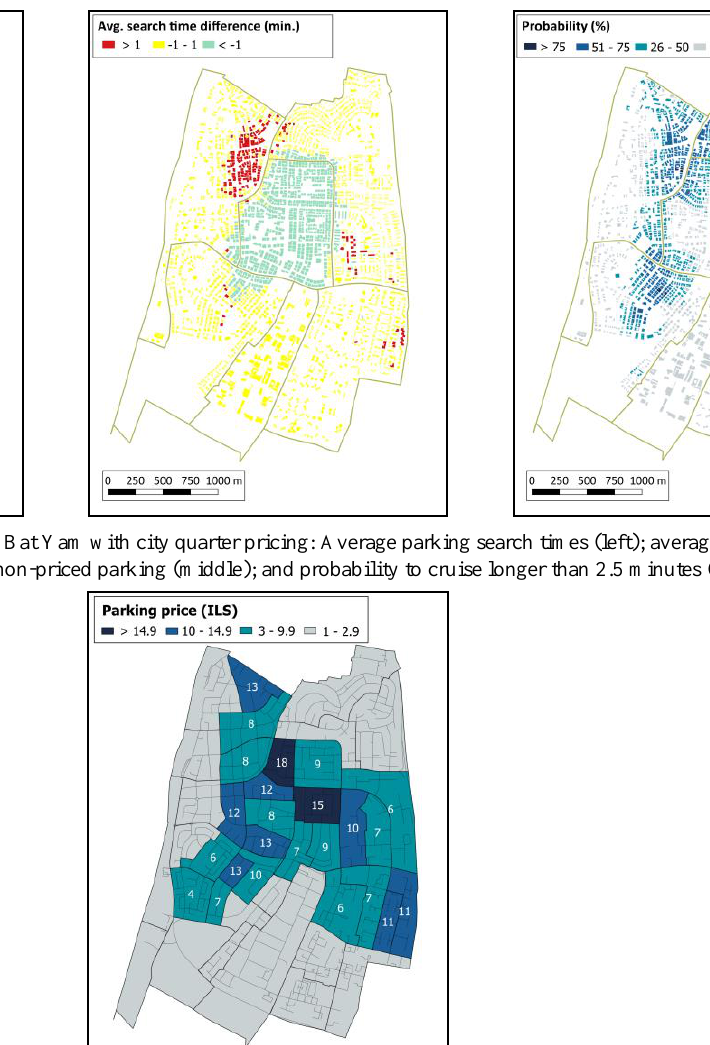
Figure 9. Bat Yam parking pricing by quarters: Average occupancy rate by street segments (left); percentage of time that street segments are fully occupied (right).